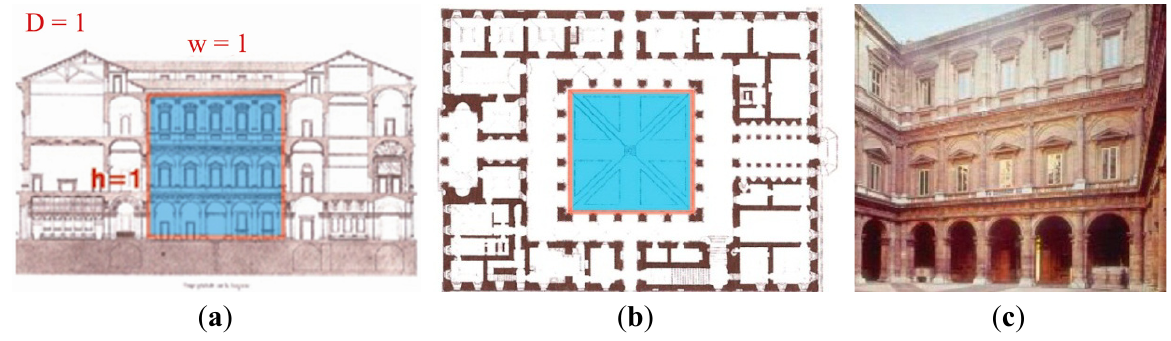
Figure 10. Courtyard of Palazzo Farnese. Rome (16 th century). Architects: Antonio da Sangallo the Younger and Michelangelo. Depth ratio of the courtyard D = 1 ( a ) section ( b ) plan ( c ) inside